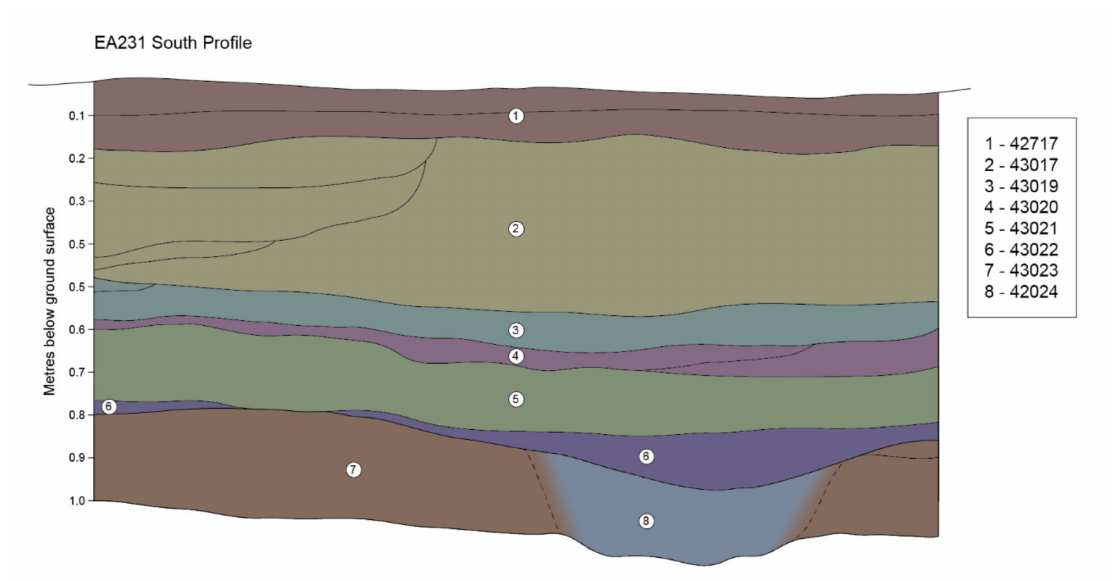
Figure 2. The stratigraphic sequence of EA231 with layer numbers. Un-numbered layers were either combined for this analysis or identified during the section drawing but not during